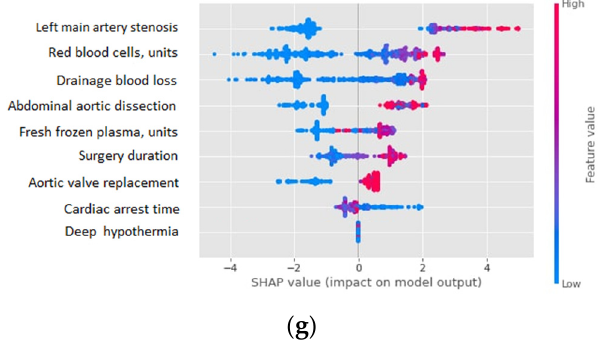
Figure 2. Feature importance diagrams for target variables: ( a ) in ‐ hospital mortality; ( b ) TND; ( c ) PND; ( d ) prolonged lung ventilation; ( e ) RRT; ( f ) MOF; ( g ) MI.